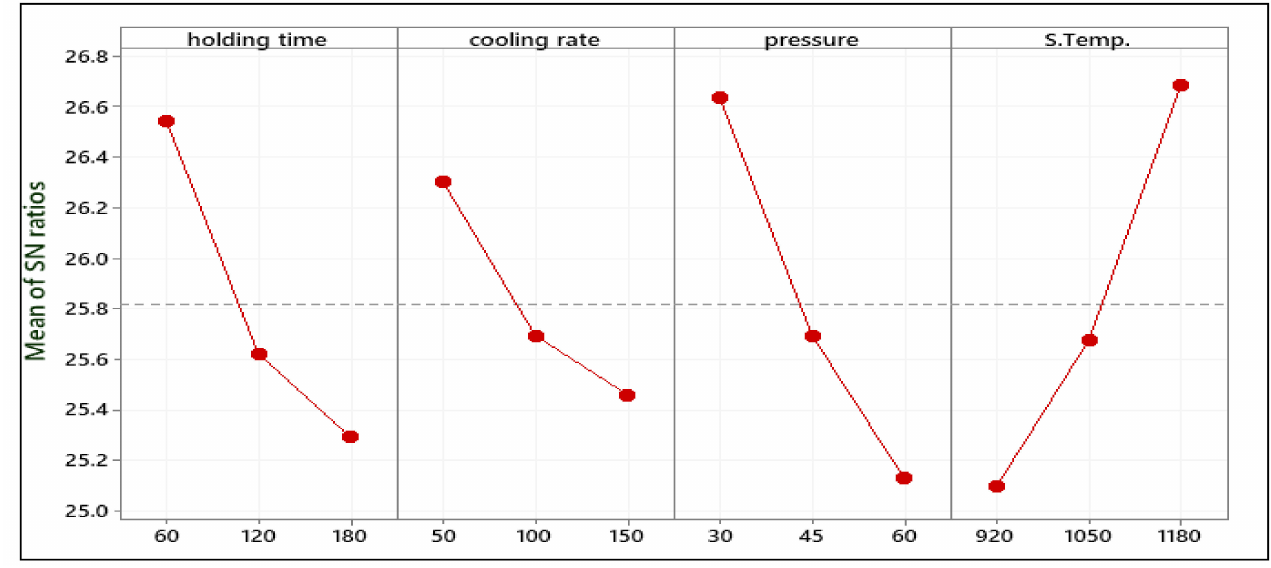
Figure 5. Mean S/N ratio of Mr (cid:107) . Table 6. Mean S/N ratio response table for Mr ⊥ .